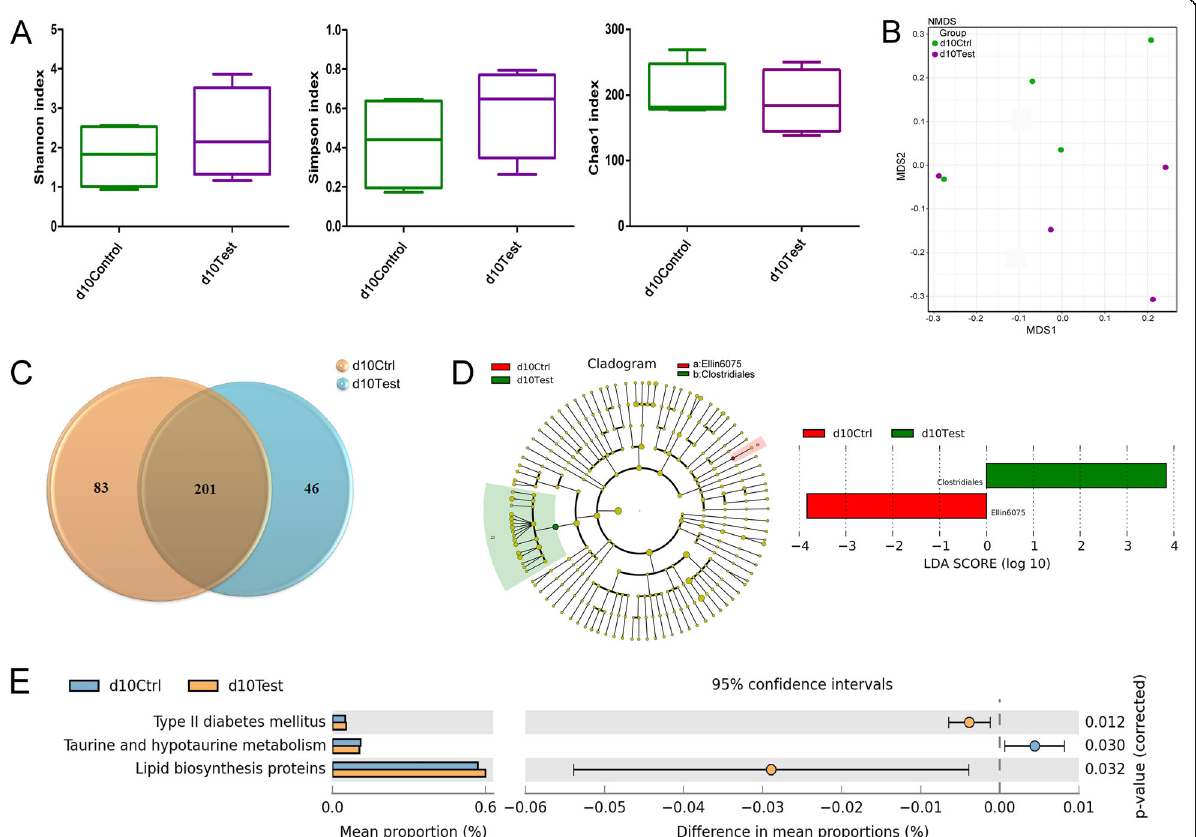
Fig. 4 Changes in the characteristics of gut microbiota between control rats and TiO 2 NP exposed rats at GD 10. a , b Alpha- and beta-diversity of gut microbiome were presented as Shannon, Simpson, and Chao1 index, as well as NMDS analysis. c Venn diagram showed the OTUs characteristics. d , e Dominant biomarkers and related gene functions were found by Lefse and phylogenetic investigation of communities by reconstruction of unobserved states (PICRUSt) prediction, respectively. D10 Ctrl means the control rats at GD 10, d10 Test means the exposure rats in GD